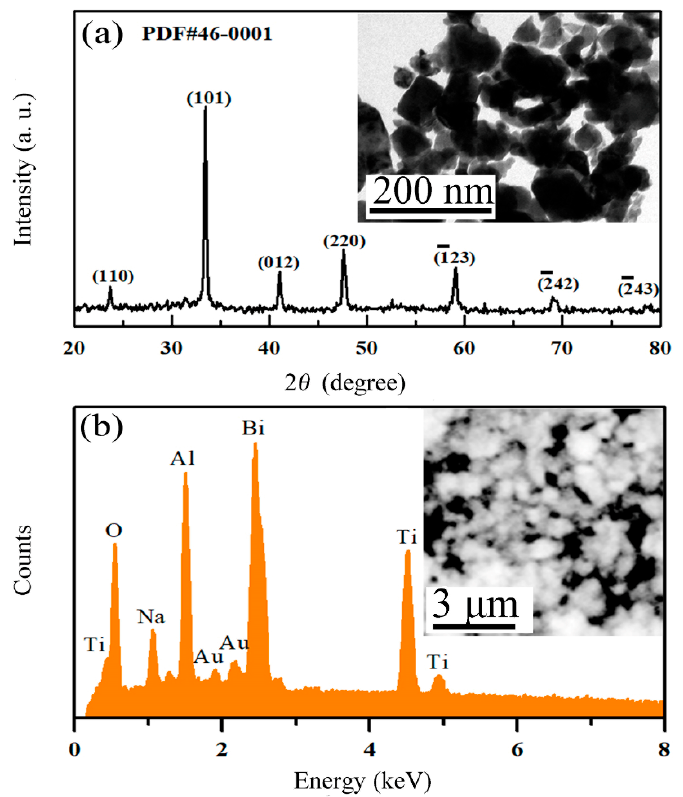
Figure 1. Microstructure characterization of BNT. ( a ) The XRD pattern. The inset is the TEM image. ( b ) EDX analysis. The inset is the SEM image.